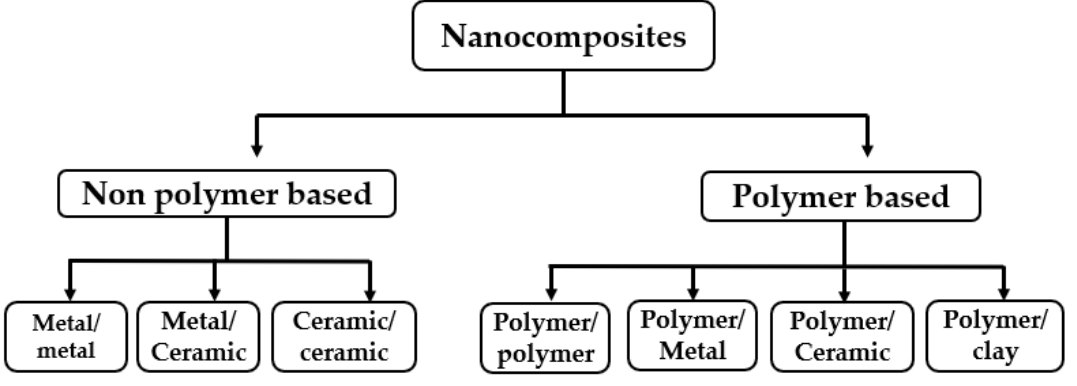
Figure 4. Classification of nano-composite [99].